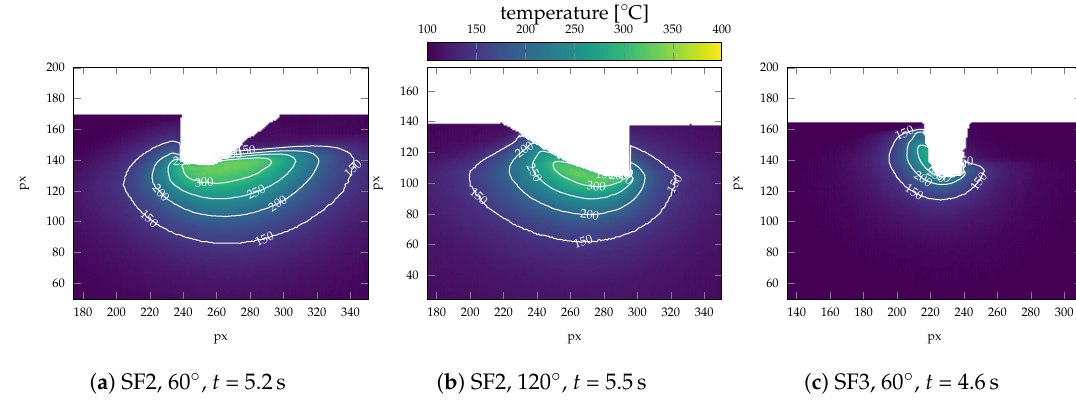
Figure 7. Images from IR camera showing foil steady-state temperature